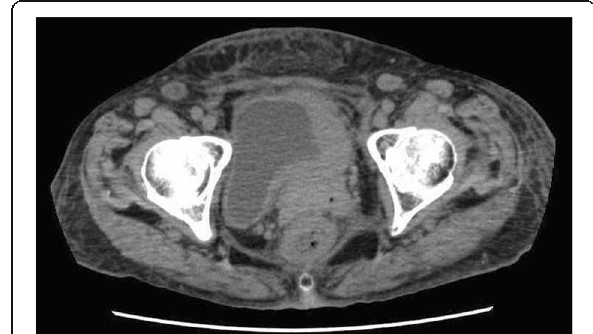
Fig. 1 Computed tomography. Thickening of the left bladder wall